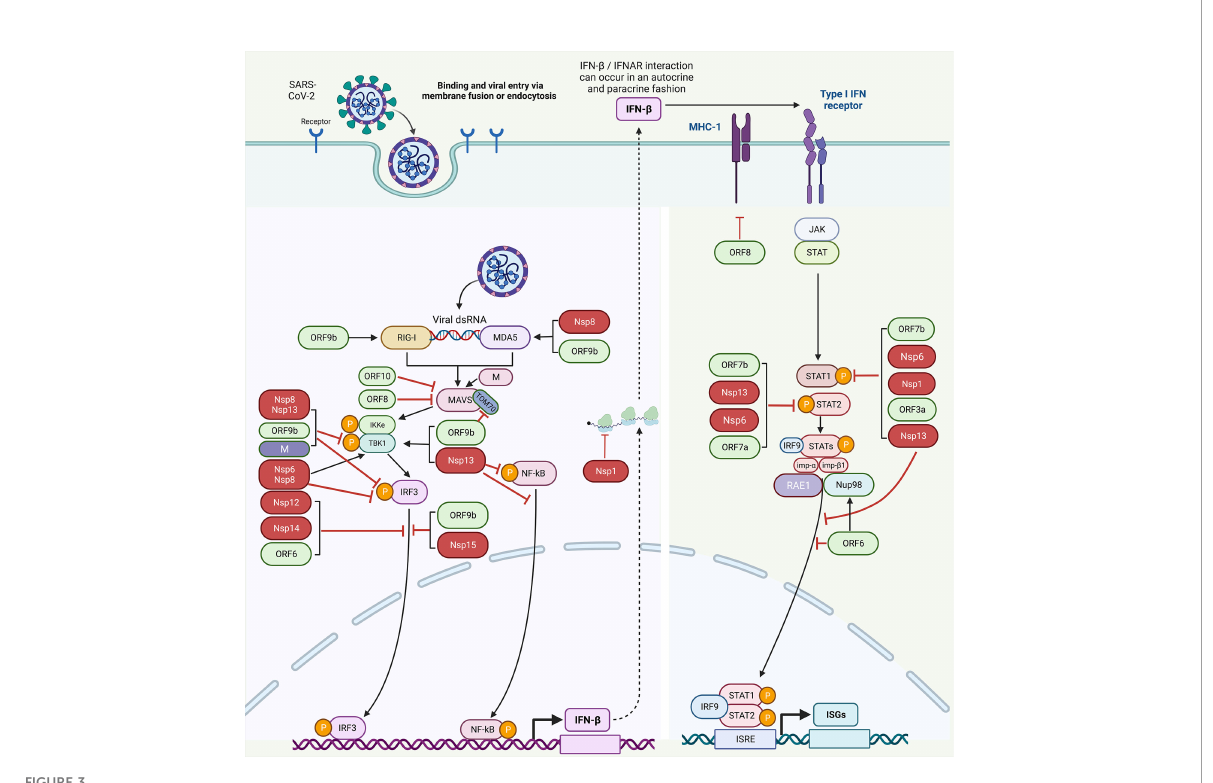
FIGURE 3 Host immune evasion by SARS-CoV-2 proteins. SARS-CoV-2 triggers IFN signaling pathway after being recognized by RIG-1 and MDA5. Different SARS-CoV-2 proteins interfere with these pathways in different ways. NSP8 and NSP13 inhibit TBK1 phosphorylation. NSP6, NSP8, NSP13, OR9b, and M inhibit IRF3 phosphorylation. NSP12, NSP14, NSP15, ORF6, and ORF9b inhibit the nuclear translocation of IRF3. NSP1, NSP6, NSP13, ORF3a, and ORF7b inhibit STAT1 phosphorylation. ORF9b inhibits TOM70. NSP6, NSP13, ORF7a, and ORF7b inhibit STAT2 phosphorylation. NSP13 and ORF6 inhibit the nuclear translocation of STAT1 to antagonize IFN signaling. ORF6 blocks STAT1 nuclear translocation by interacting with the Nup98-RAE1 complex and disrupts the interaction between Nup98 and importin- b 1/importin- a 1/PY-STAT1 complex, thus preventing the docking of this complex at the nuclear pore. ORF8 inhibits MHC-I to impair antigen-presenting cells. [NSP, non- structural protein; ORF, open reading frame; TOM70, translocase of outer membrane 70 KDa Subunit; IFN, interferon; STAT, signal transducer and activator of transcription; IRF3, interferon regulatory factor 3; IRF9, interferon regulatory factor 9; NF- k B, nuclear factor- k B; ISGs, interferon-stimulated genes; MHC-I, major histocompatibility complex I; Nup98-RAE1 complex, nucleoporin 98 (Nup98) – ribonucleic acid export 1